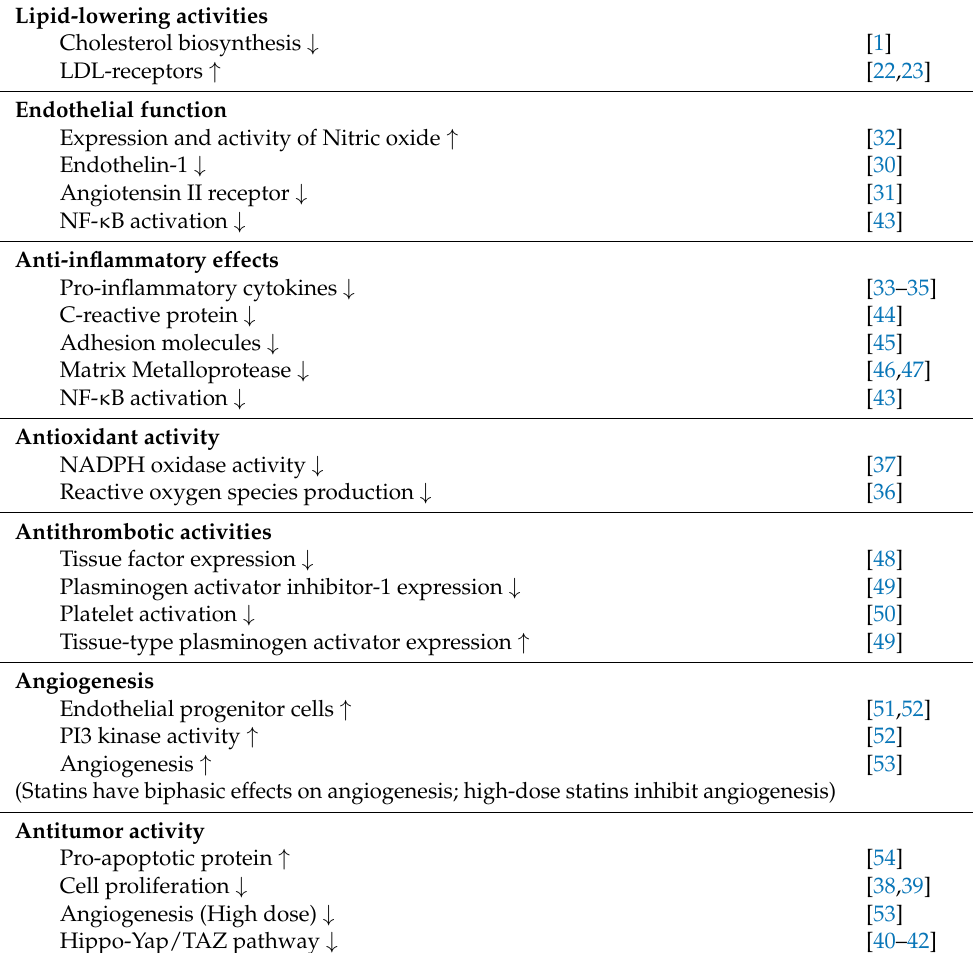
Table 1. Possible mechanisms of statins on cardiovascular and cerebrovascular diseases and